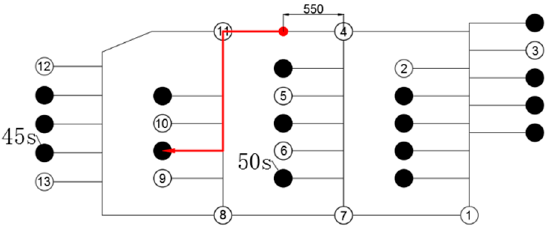
Figure 8. Real-time condition of the parking lot.